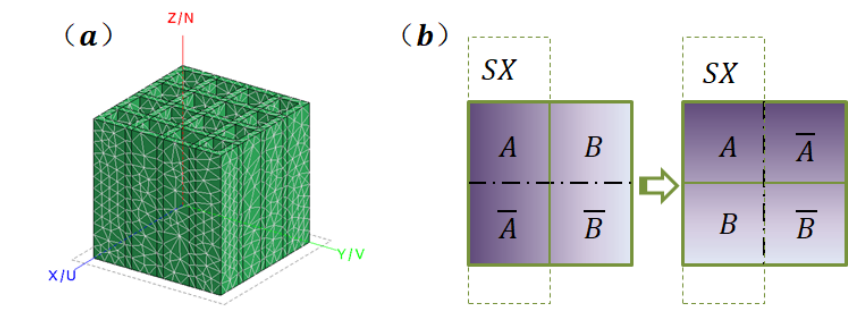
Figure 3. Physical model of a periodic-arranged material with ( a ) periodic-arranged cross-section and ( b ) composition of subspace SX with materials A and ¯ A for a priori distribution and with materials A and B for the posterior distribution,